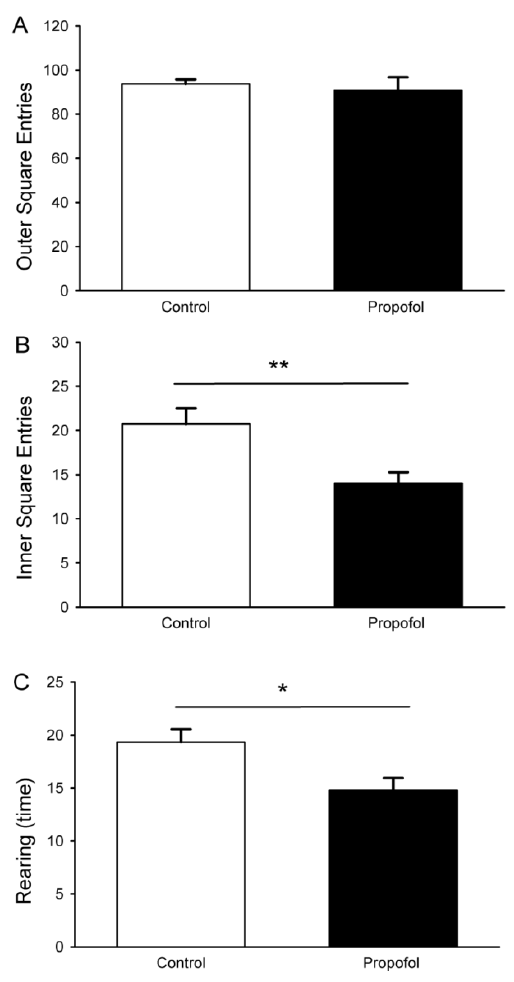
Figure 6. Effect of propofol administered to pregnant rats on the performance of offspring rats (P28) in the open field task. Pups exposed to propofol in utero made significantly fewer entries into the inner squares ( B ) and number of wall rears than age-matched control pups ( C ). No major difference in the outer square entries ( A ). Data are means ± SEM. Student t test. N = 6, 3 pups per litter, n = 18 for control; N = 6, 2–3 pups per litter, n = 16 for propofol group. For all figures, asterisks represent statistical difference ( * p < 0.05; ** p < 0.01).